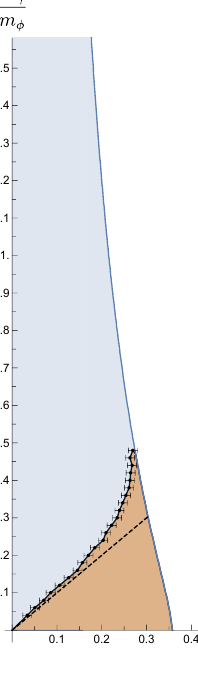
Figure 19 . Numerical survey of vortex types in parameter space ( m χ /m φ , m γ /m φ ) . The white region on the right hand side corresponds to Abelian vortices (of type II since m γ /m φ < 1 ), whereas shaded regions to its left correspond to non-Abelian ones. Type I* non-Abelian vortices are found in the upper-left region (light-blue shading), while type II non-Abelian vortices are found in the lower-left one (orange shading). The dashed black line marks the analytic approximation to the type I* – type II non-Abelian boundary found in section 4.2.2, with the actual boundary being shifted to higher m γ /m φ